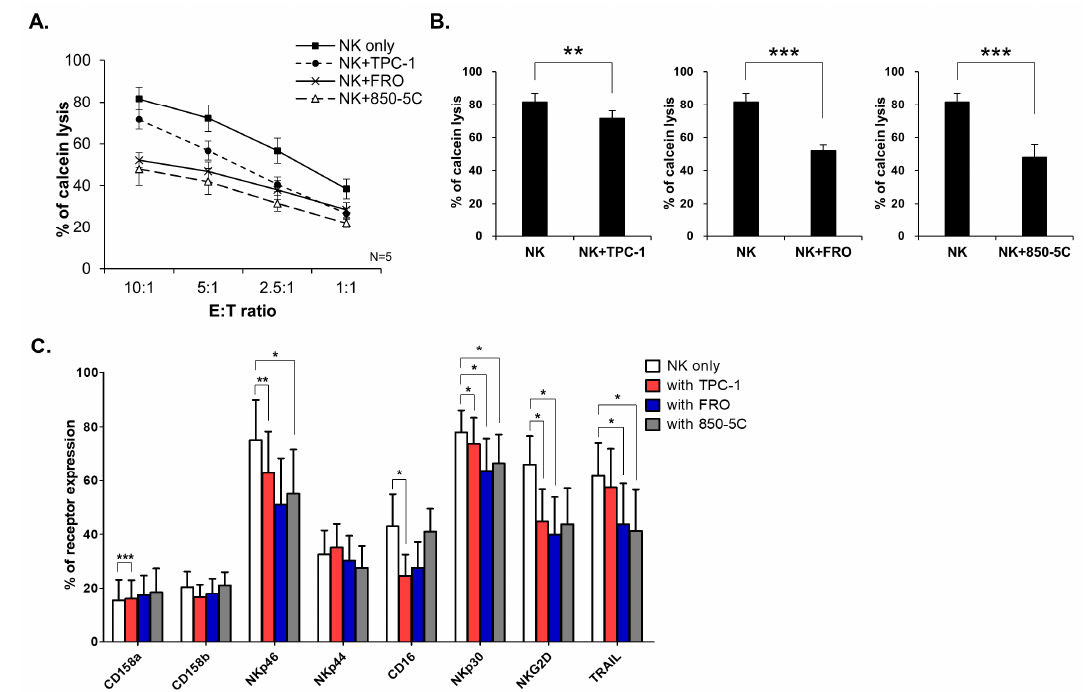
Figure 1. Thyroid cancer cells inhibit natural killer (NK) cell cytotoxicity and NK receptor expression. ( A ) NK cells were cultured without thyroid cancer cells (square) or co-cultured with TPC-1 (circle), FRO (cross), and 850-5C (triangle) in the medium containing IL-2 for 24 h. The cytotoxicity of NK cells